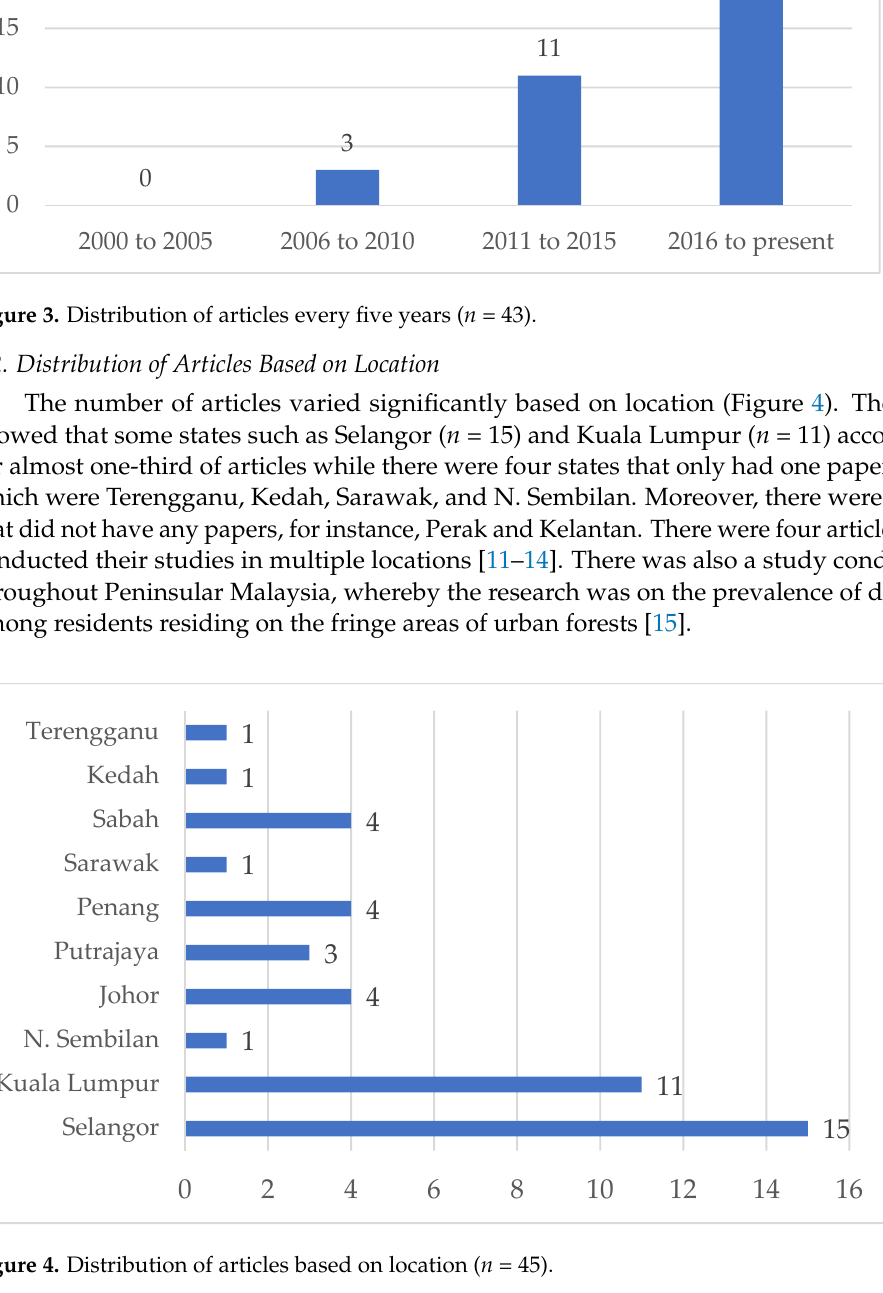
Figure 2. Distribution of articles by year ( n = 43).